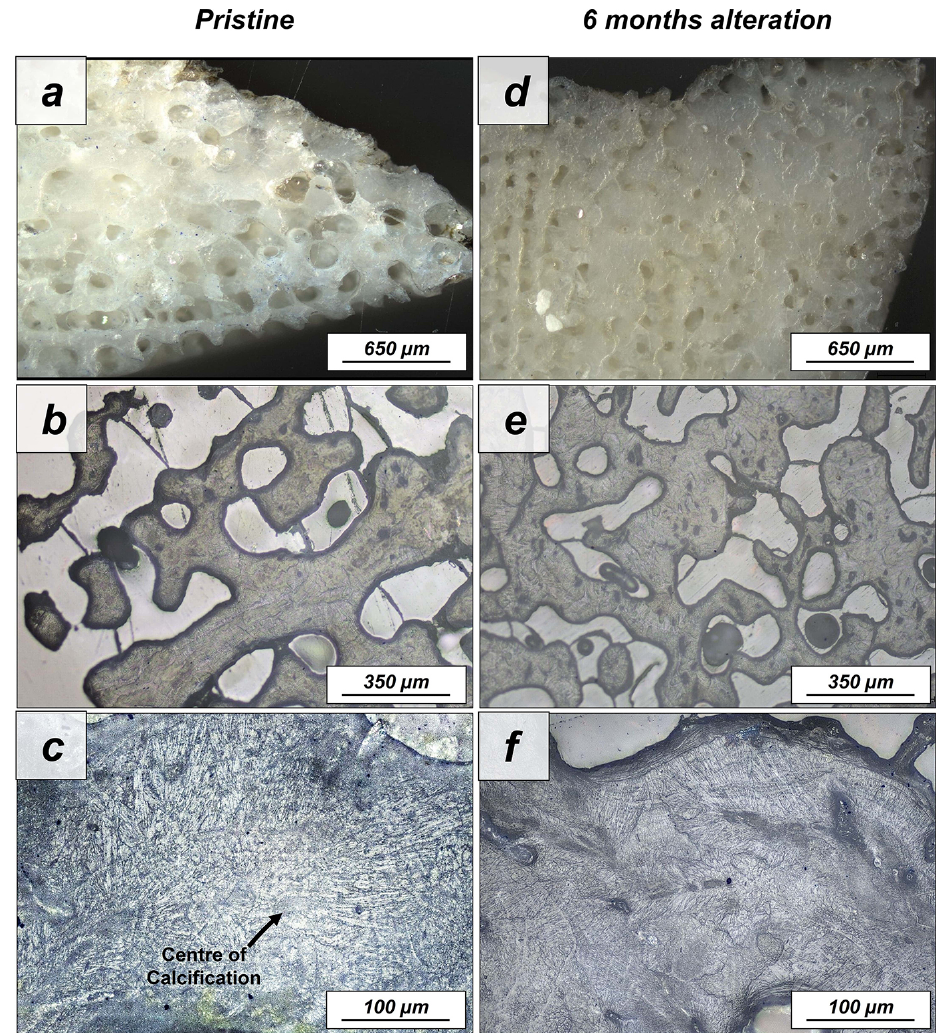
Figure A11. Laser confocal microscopy images of (a–c) the pristine and the (d–f) altered skeleton of Porites sp. This coral species has a huge primary porosity, while the aragonitic hard tissue itself is densely mineralized (a–c) . Aragonite acicles, needles and fibrils grow out of centres of calcification (a) . Hydrothermal alteration for 6 months at 80 ◦ C in a Mg-rich fluid does not induce significant changes to the skeleton microstructure, as visible in panels (d) – (f)